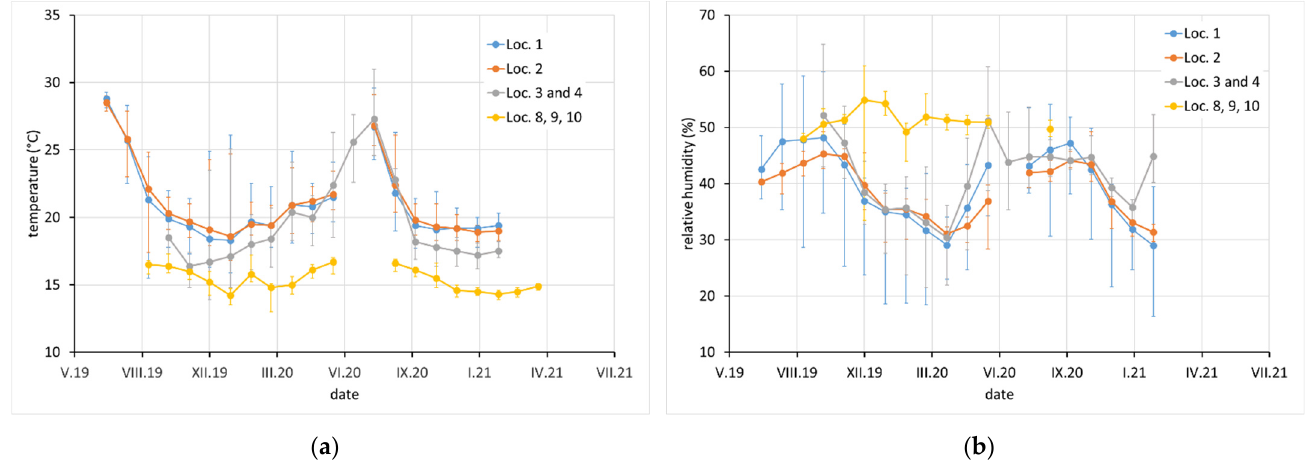
Figure 2 . ( a ) Temperature and ( b ) relative humidity record at locations 1, 2, 3, 4, 8, 9, and 10. Points indicate average monthly values and error bars indicate monthly minimum and maximum.